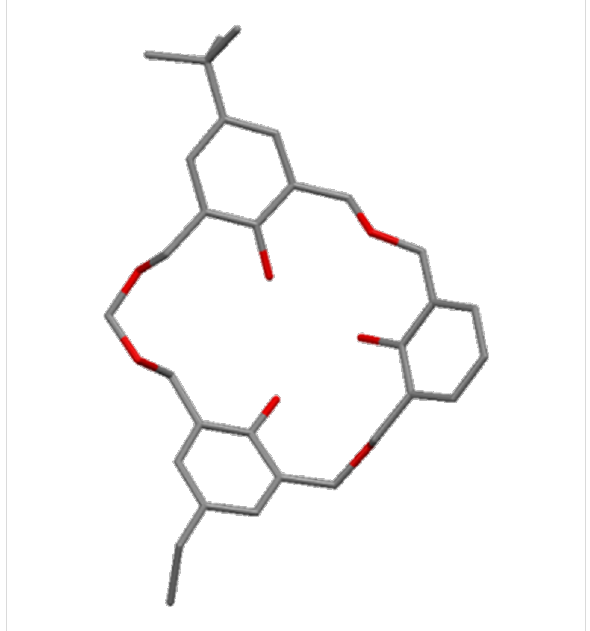
Figure 5: X-ray crystal structure of heptahomotetraoxacalix[3]arene 5 (CCDC ID 166088) [21].